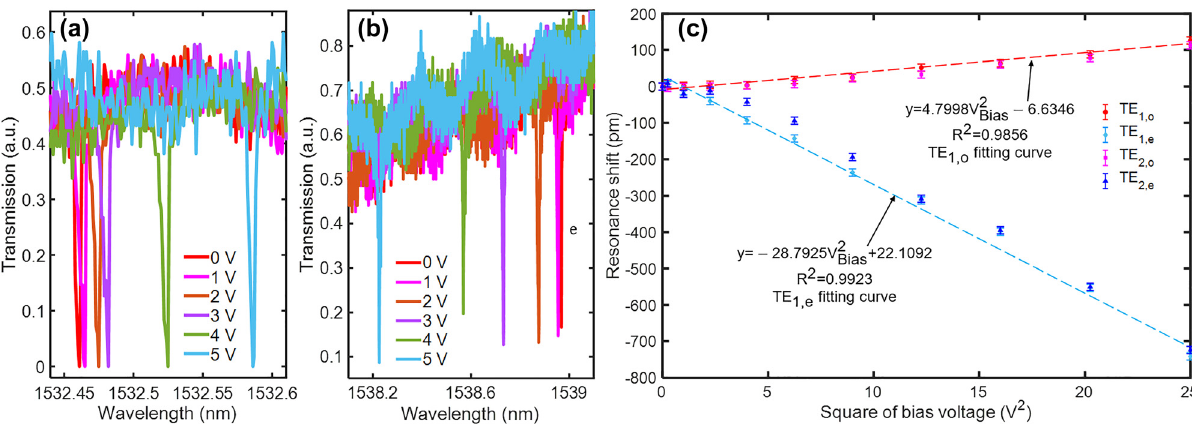
Figure 5: Electrostatic force-induced optical resonance shift of the zipper cavity. (a) and (b) optical resonant wavelength shift of TE 1,o and TE 1,e under the increasing applied bias voltages. (c) Resonance shift of the fundamentalandsecond-order opticalmodesundertheincreasingbiasvoltages(from0 V to5V,step0.5V)witha linear fi ttingto identifythe dispersion